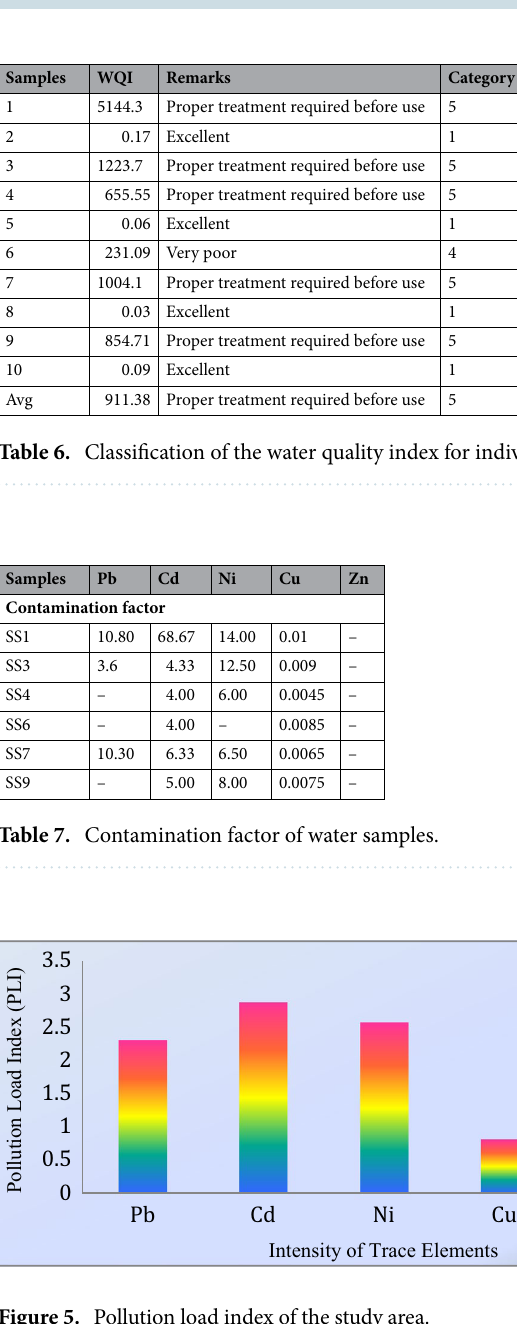
Figure 5. Pollution load index of the study